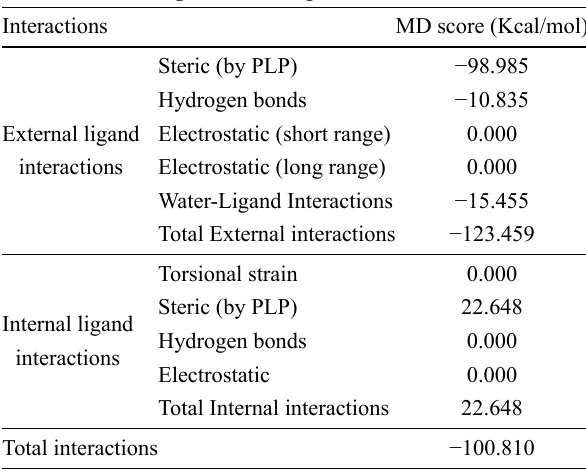
Table 2. Moleclar docking data ftom interaction between genistein and p38MAPK.